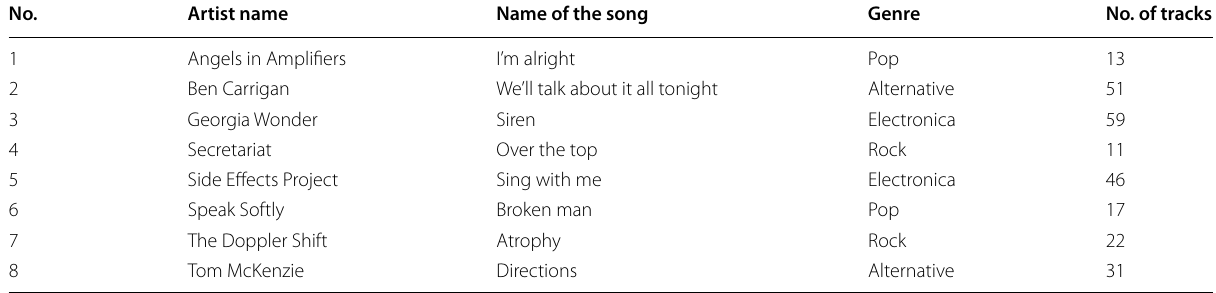
Table 2 List of selected songs